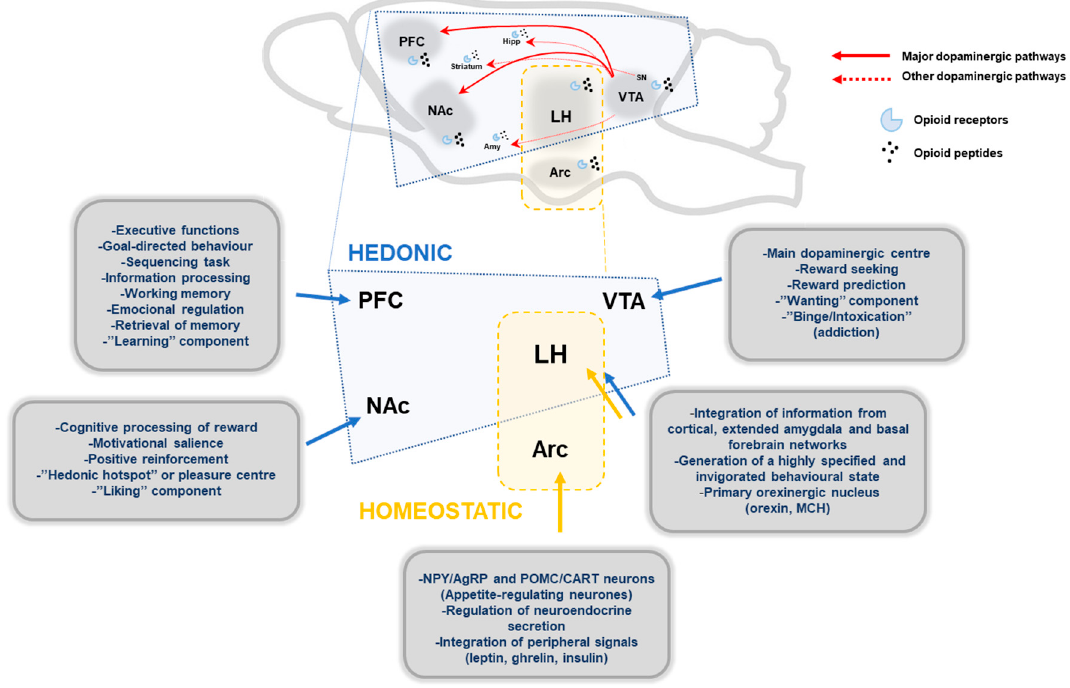
Figure 1. Schematic representation of main brain structures implicated in hedonic and homeostatic food intake regulation. Main dopaminergic pathways, mesolimbic and mesocortical pathway, are represented with red lines, and other minor dopaminergic connections with broken red lines.